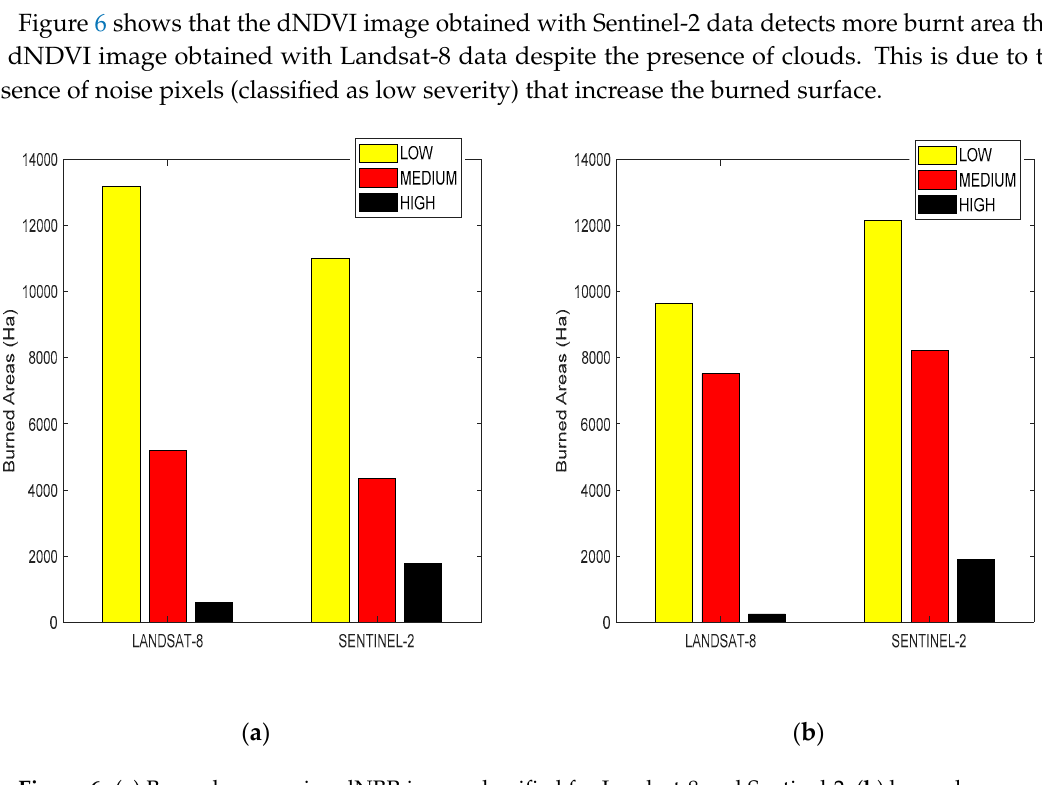
Figure 6. ( a ) Burned areas using dNBR image classified for Landsat-8 and Sentinel-2; ( b ) burned areas using dNDVI image classified for Landsat-8 and Sentinel-2.